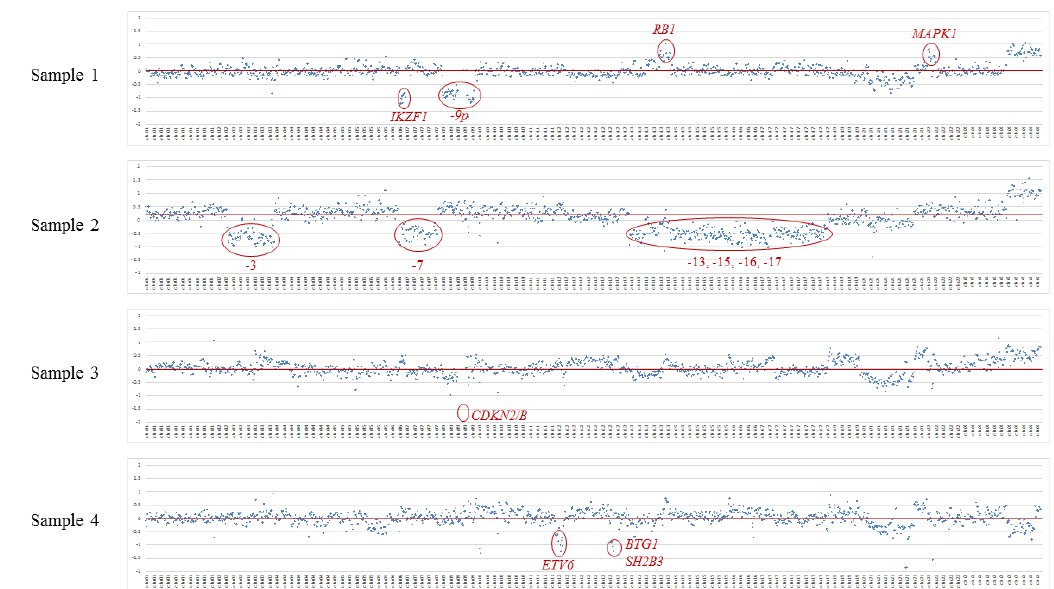
Figure 2. Copy number variation (CNV) analysis by massively parallel sequencing. Log2 ratios of normalized mean coverage of each target were plotted against the reference. The x -axis is the corresponding targets in the panel, plotted by relative genome order, and the y -axis shows the log2 ratio of mean coverage of testing to that of reference. CNVs were called using fixed thresholds representing the minimum log2 ratio for gains (0.55) and maximum log2 ratio for losses (−0.55).